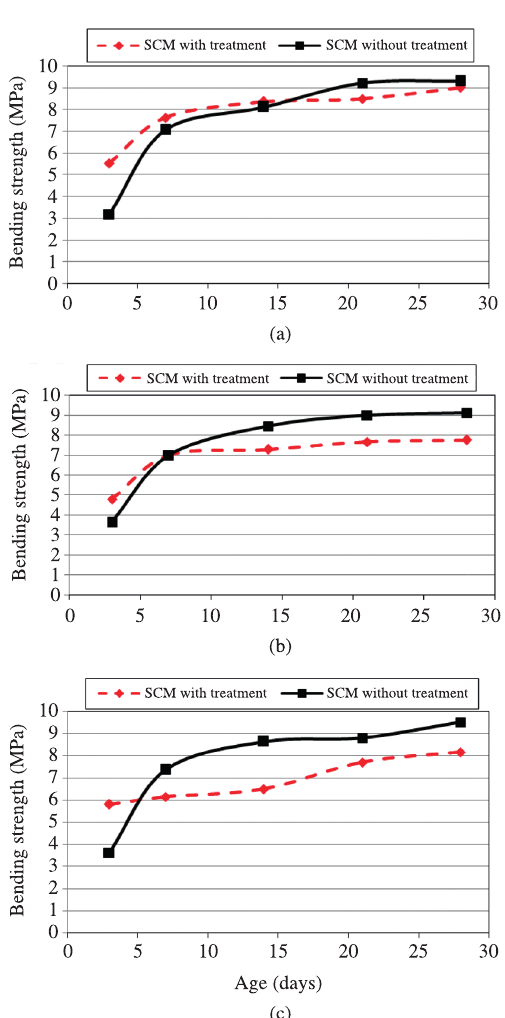
Figure 5. The bulk density of SCM mortars studied.